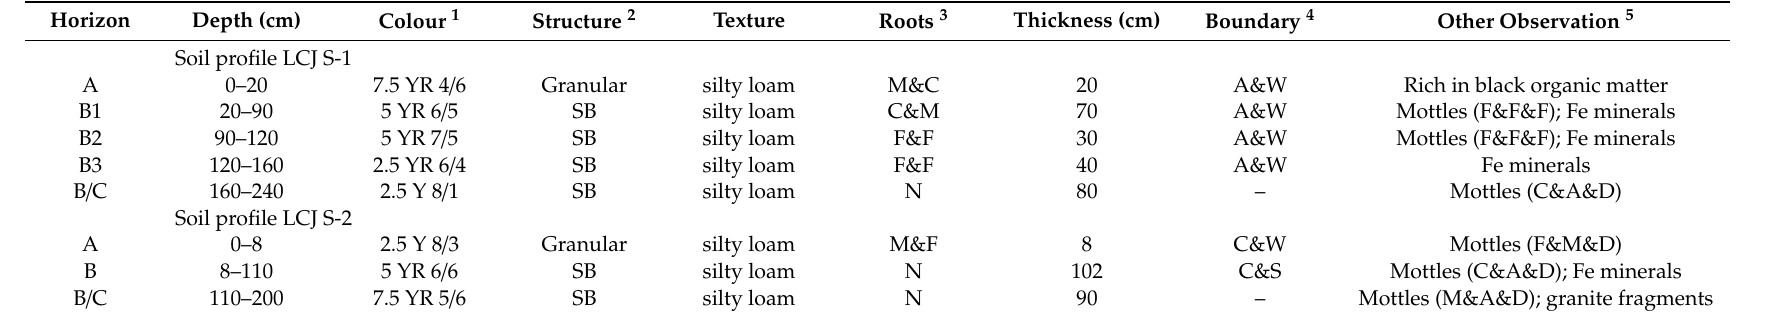
Table 1. The descriptions of the two soil profiles in the Lancangjiang River